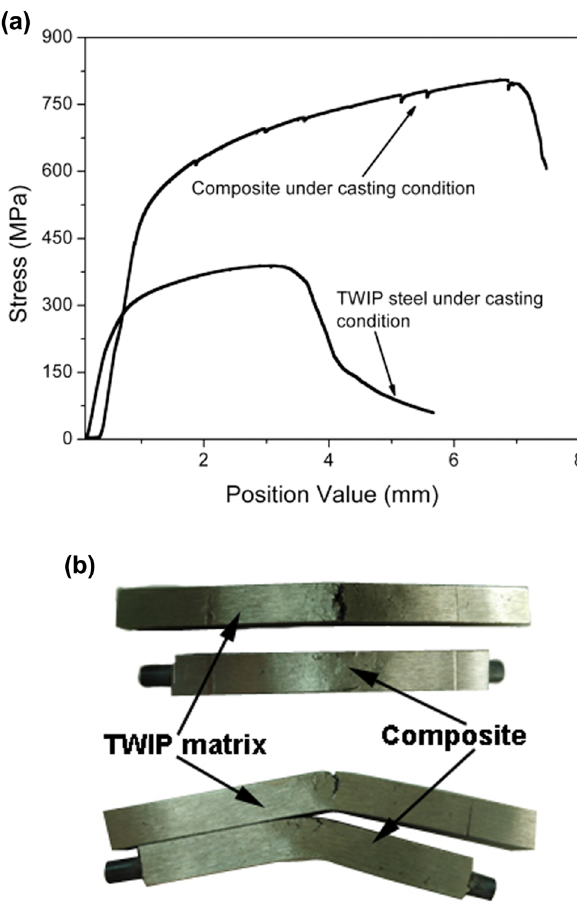
Figure 6: Bending curves ( a ) and specimens after bending test ( b ) .